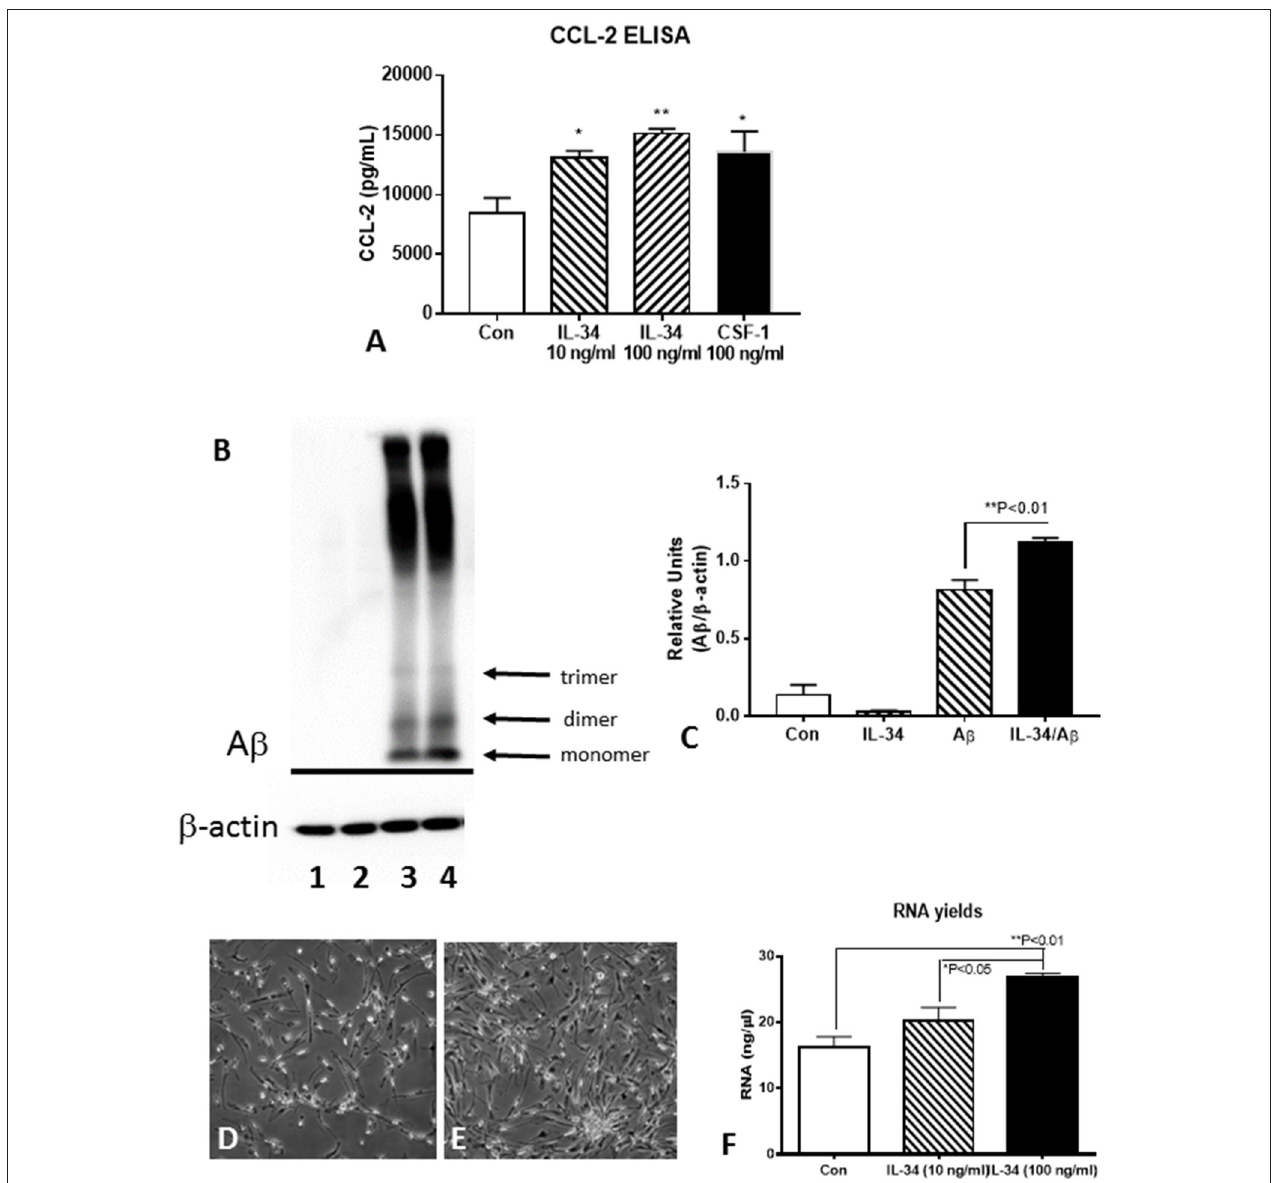
FIGURE 7 | Effect of IL-34 on microglial functional properties. (A) ELISA measurements of CCL-2 from control, IL-34, and CSF-1 stimulated microglia. (B,C) . Effect of IL-34 on levels of A β (42) (1 µ M) in treated microglia. (B) Representative western blot showing pattern of immunoreactivity for aggregated A β in treated microglia for 24 h. (C) Quantification of A β present in microglia after 24 h. Lane 1. Control untreated microglia: Lane 2. IL-34-treated microglia: Lane 3. A β (1 µ M) treated microglia: lane 4 IL-34, and A β -treated microglia. (D–F) IL-34 effective at inducing significant cell division in human postmortem microglia. (D) Microglia treated without IL-34 for 4 days (representative field). (E) Microglia treated with IL-34 (100 ng/ml) showed significant increase in numbers. (F) Effect of IL-34 on total RNA yield of microglia treated for 4